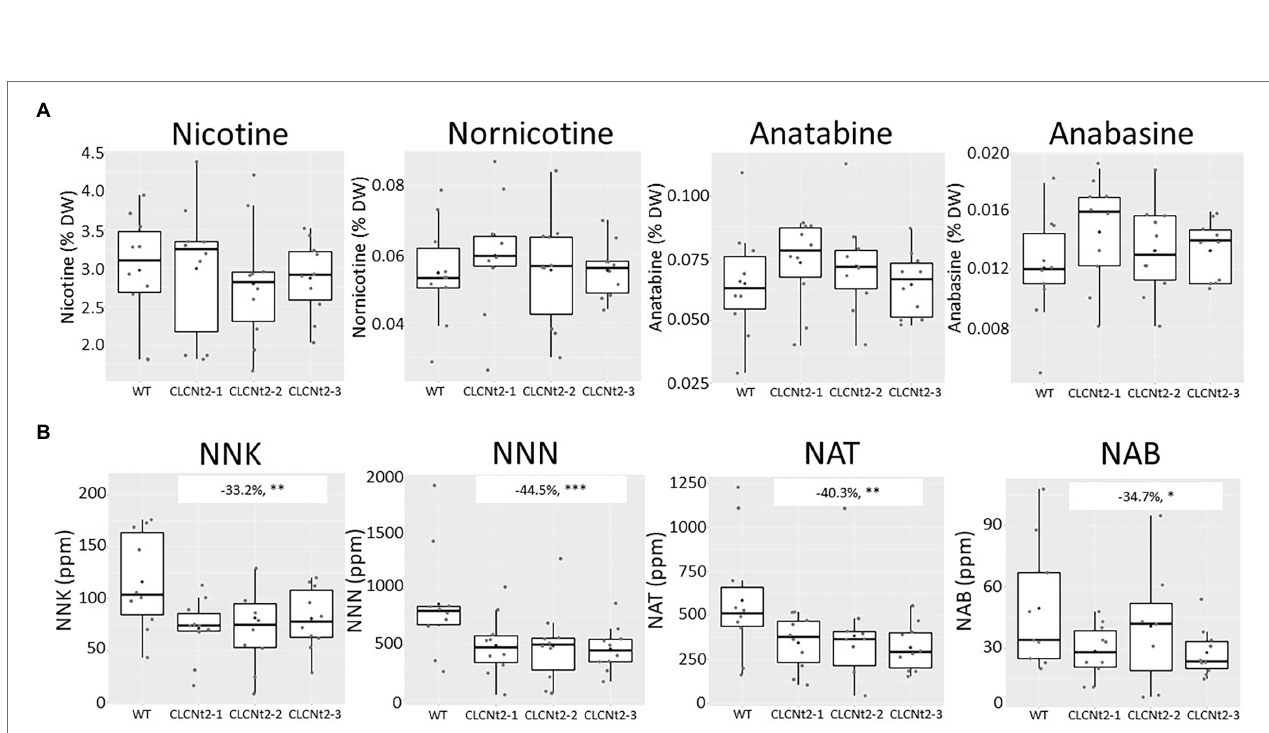
FIGURE 4 | Alkaloid (nicotine, nornicotine, anatabine, and anabasine) and TSNA (NNK, NNN, NAT, and NAB) content in the cured leaf lamina of CLC-RNAi (CLC2- 1, CLC2-2, and CLC2-3) and WT plants grown in the field. Data were collected from 10 plants randomly selected after curing. The charts represent the box plots of genotypic groups, with no significant differences in alkaloid content between the WT and CLCNt2 lines (A) . For TSNA content (B) , the difference observed in NNK levels between the CLCNt2-1 lines and WT was − 33.2% ( − 10.6, − 55.8%), p = 0.018**; for NNN levels, the difference observed between the WT and CLCNt2 lines was − 44.5% ( − 19.8, − 69.1%), p = 0.004***; for NAT levels, the difference observed between the WT and CLCNt2 lines was − 40.3% ( − 14.4, − 66.2%), p = 0.013**; for NAB levels, the difference observed between the WT and CLCNt2 lines resulted in − 34.7% ( − 4.7, − 64.6%), p = 0.058*. An ANOVA test with a CI of 90% was